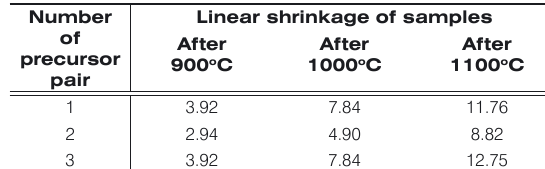
Table 3 . Linear shrinkage (%) of the samples after sintering at 900 o C, 1000 o C, 1100 o